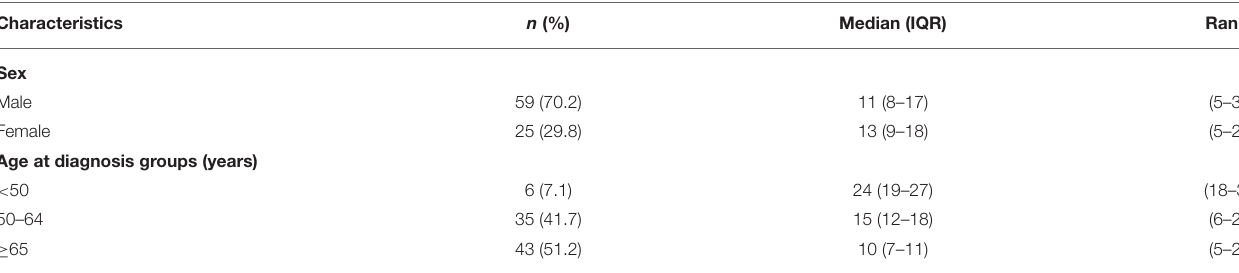
TABLE 4 | Survival time post diagnosis for the Parkinson’s patients.